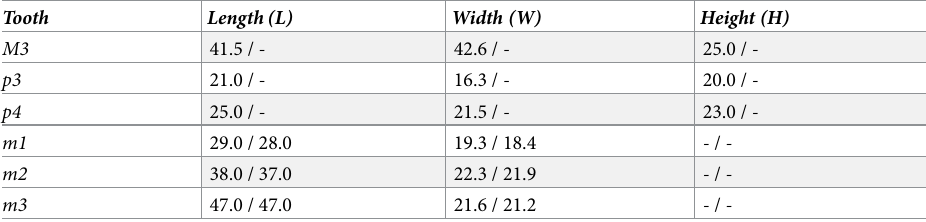
m3 47.0 / 47.0 - / - The measurements are presented as